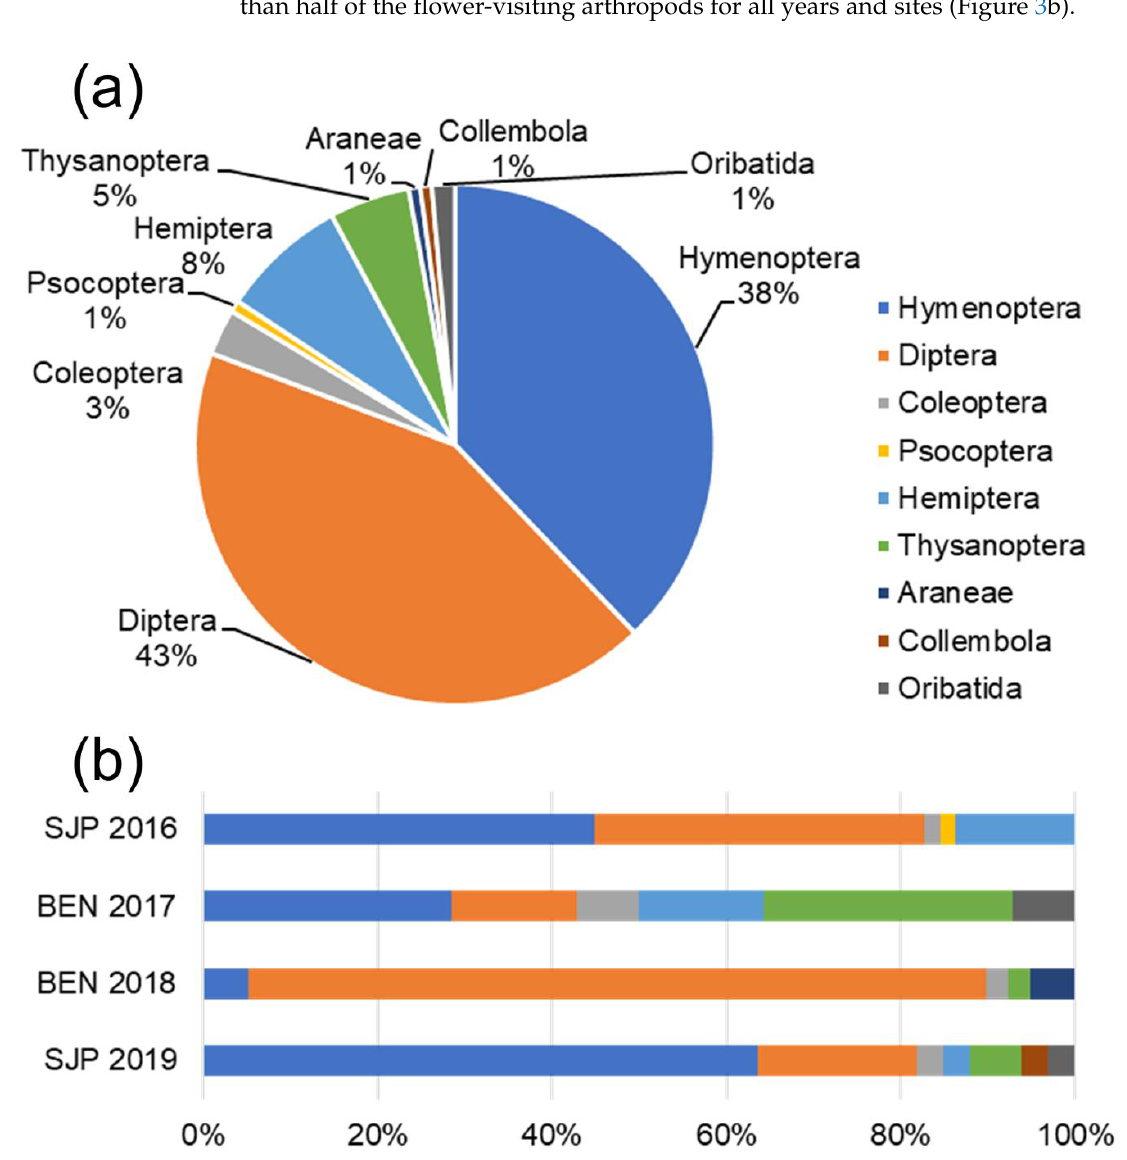
Figure 3. Arthropods sampled by timed observations: overall ( a ) and yearly composition at the two sites ( b ) of the flower-visiting arthropod community to order sites ( b ) of the flower-visiting arthropod community to order level.